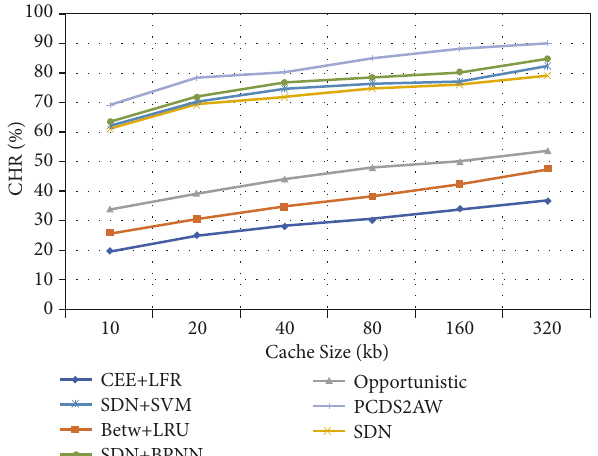
Figure 6: Effect of cache size.